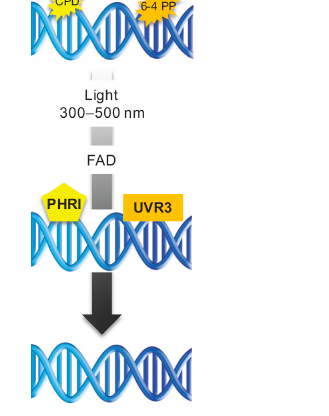
Figure 1. Direct repair (DR) pathway. Schematic representation of the light-dependent repair pathway of cyclobutane pyrimidine dimer (CPD)- and 6–4-photoproducts (6–4 PP)-induced DNA damage.